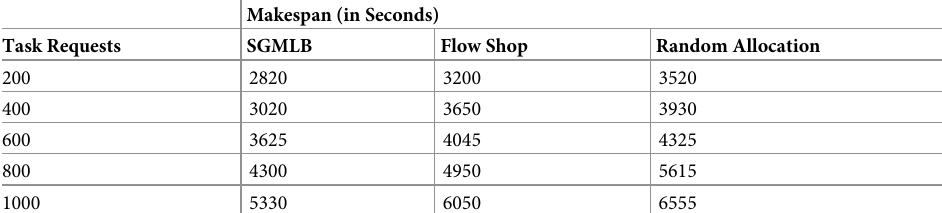
Table 1. Makespan values in seconds for different task